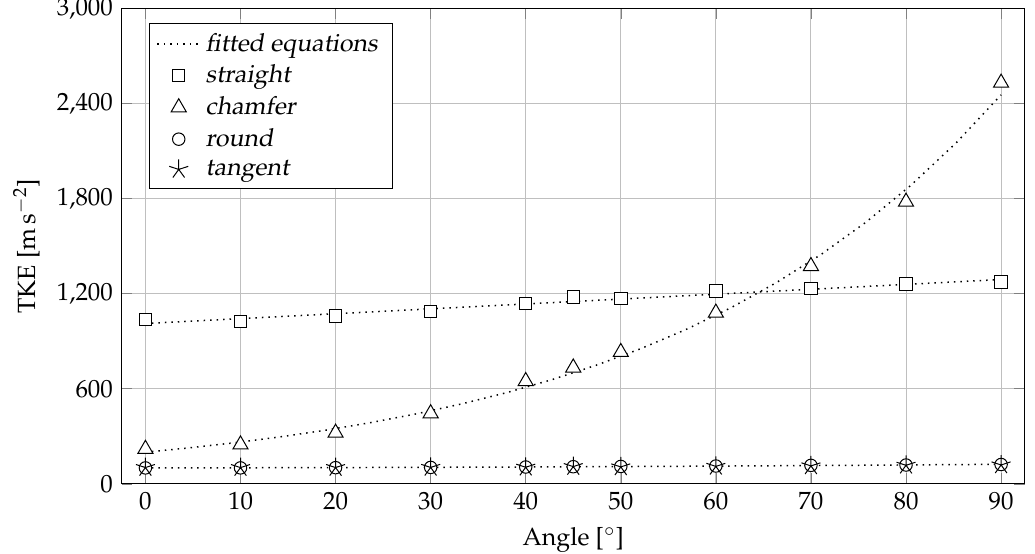
Figure 5. TKE sums for every case. All relations between energy loss and angle of alignment were significant ( p <